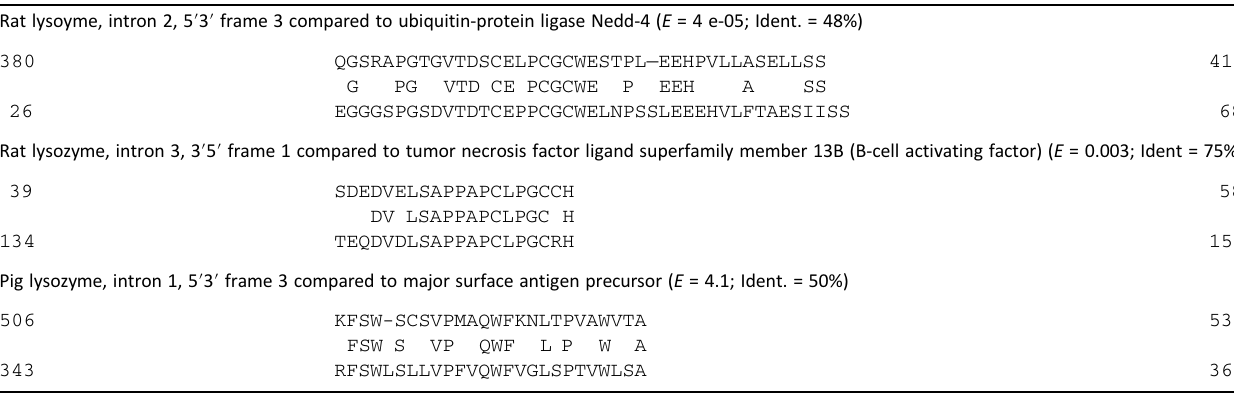
Table 2. Comparison of two translated rat intron and one translated pig intron lysozyme sequences with fragments of biologically act- ive proteins. (For further details, see legend to Table